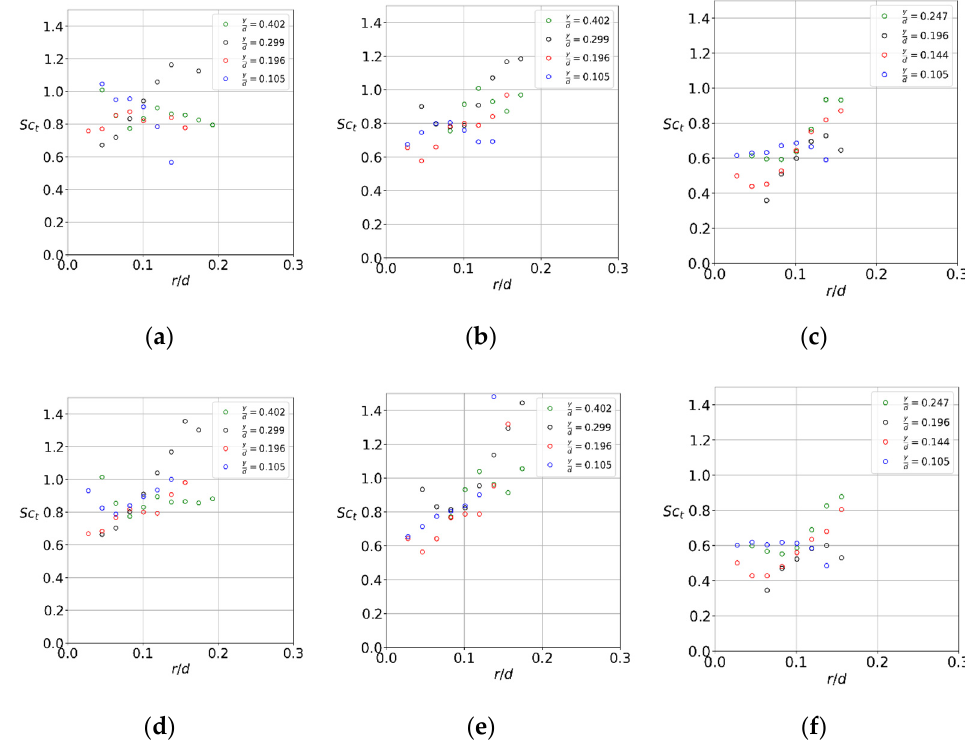
Figure 20. Turbulent Schmidt number for ( a ) methane, ( b ) neon, ( c ) air, and ( d – f ) the corresponding stochastic parts for gas turbine swirler.